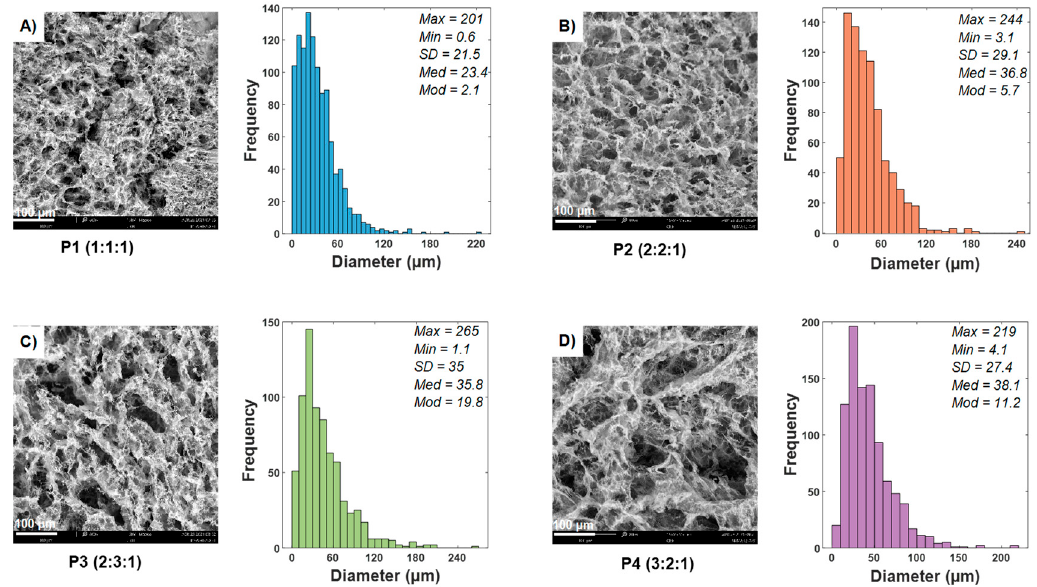
Figure 4. SEM images of ternary blend scaffolds ( A ) 1:1:1, ( B ) 2:2:1, ( C ) 2:3:1 and ( D ) 3:2:1. The scale bars are shown in the micrographs.